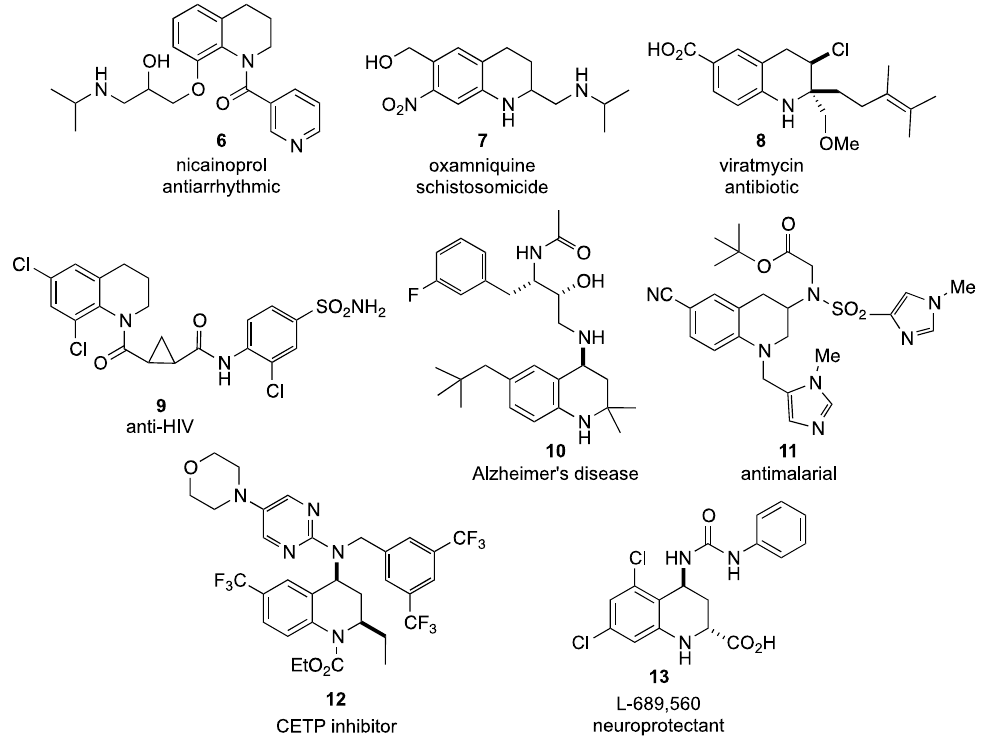
Figure 2. Drugs incorporating